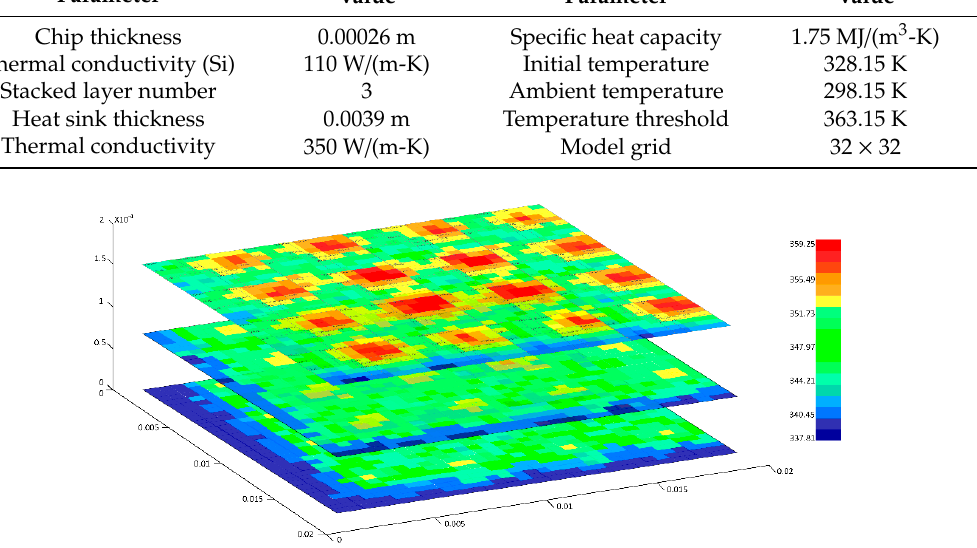
Figure A1. Thermal profile of proposed 3D three-layer architecture (steady temperature evaluated, size scale in Meter, temperature in Kelvin).